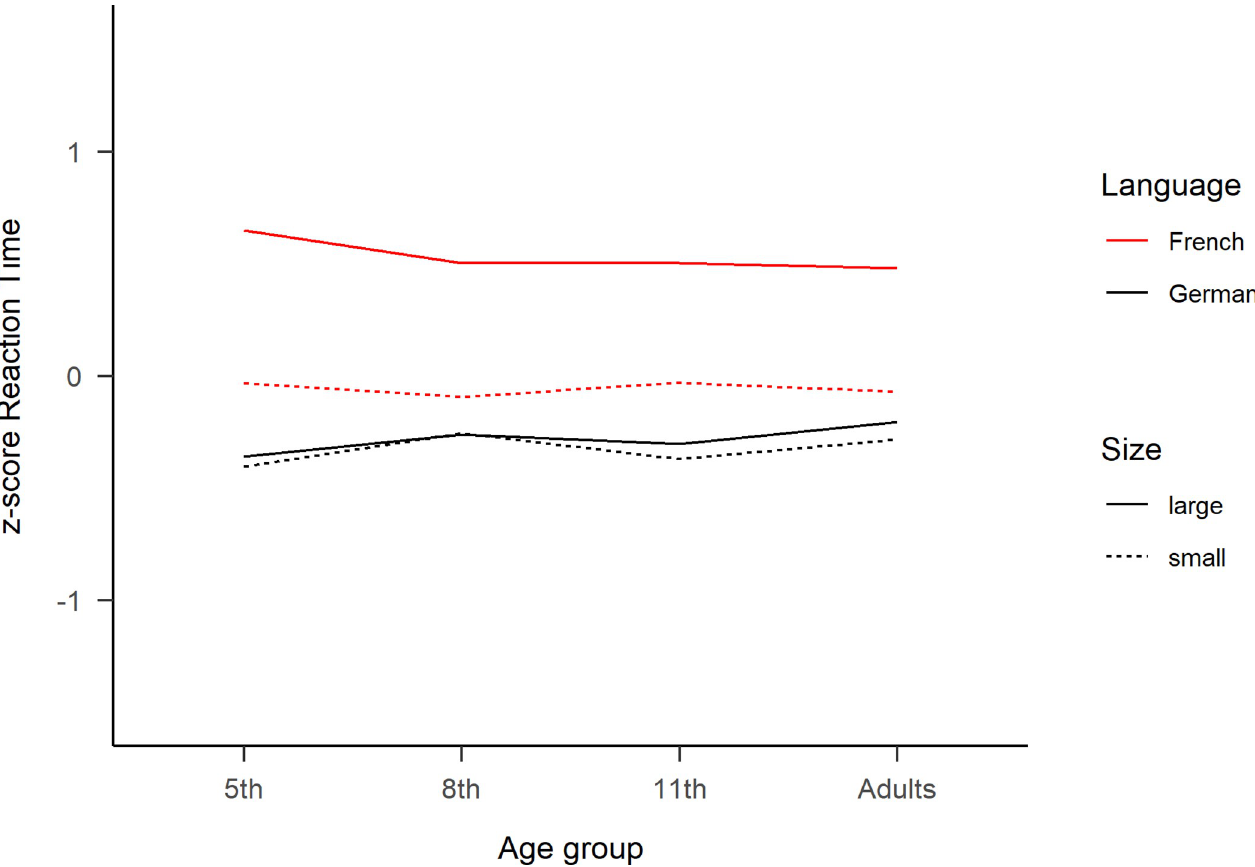
Fig 6. Z-score reaction times of the verbal-visual matching task. Standardized reaction times for each age group as a function of “Language” and “number Size”. Large numbers correspond to ‘70s, ‘80s and ‘90s, while small numbers correspond to ‘30s, ‘40s and ‘50s.